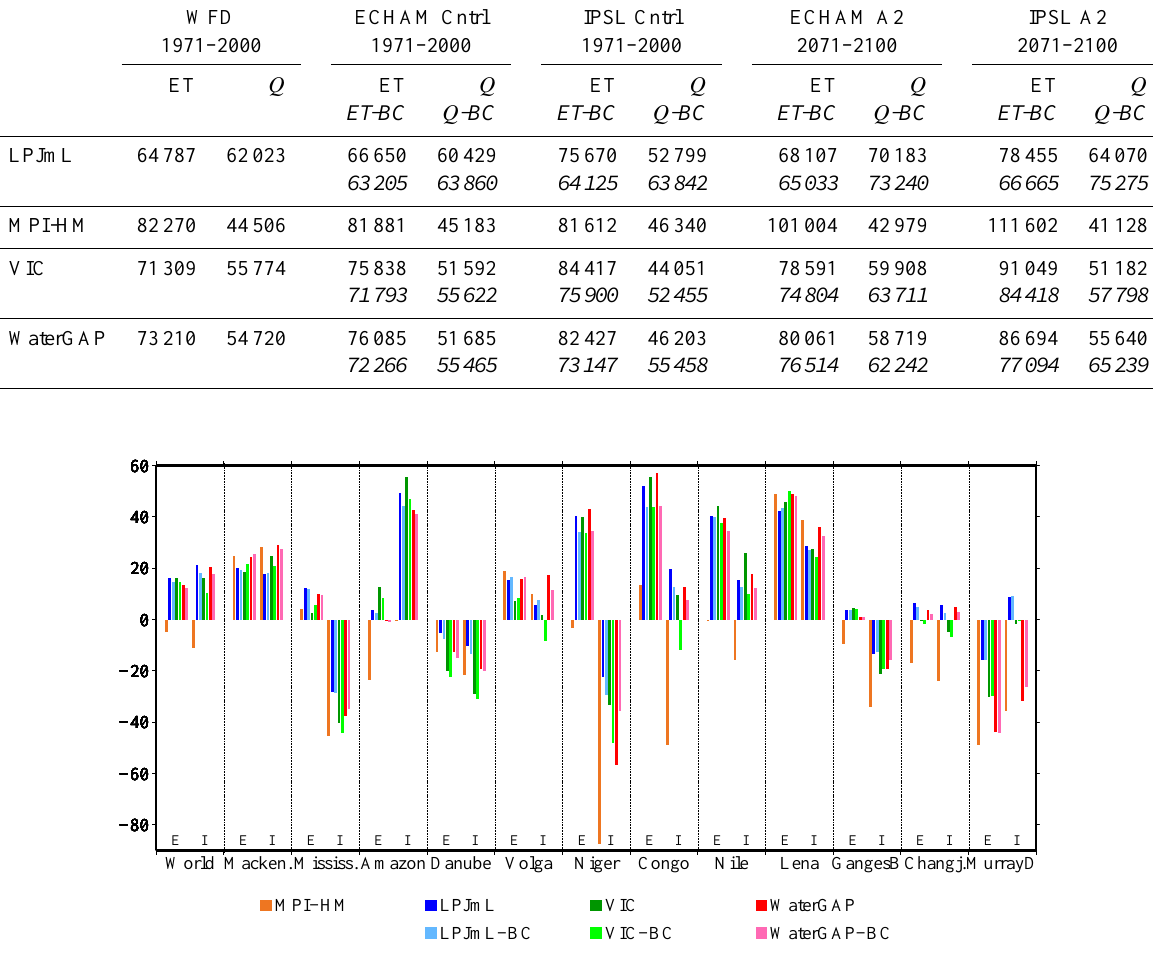
Fig. 9. Projected annual mean runoff changes (percent), with and without bias correction (BC) in 2071–2100 relative to 1971–2000 for the MPI-HM, LPJmL, VIC and WaterGAP models when using ECHAM (E) and IPSL (I) input datasets.